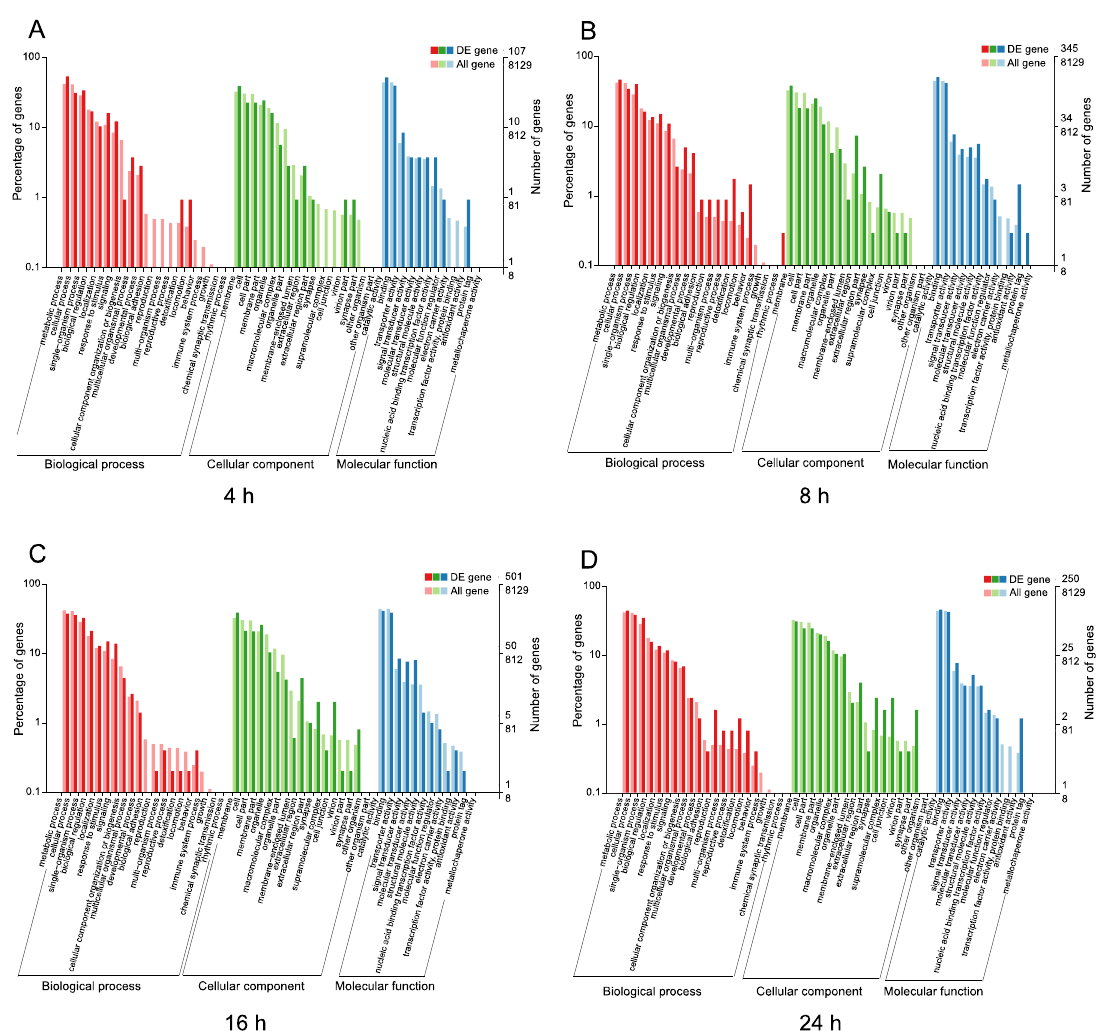
Figure 3. Gene Ontology (GO) categories of N. lugens DEGs after challenge with M. anisopliae at different periods. A: GO categories of N. lugens DEGs after challenge with M. anisopliae at 4 h; B: GO categories of N. lugens DEGs after challenge with M. anisopliae at 8 h; C: GO categories of N. lugens DEGs after challenge with M. anisopliae at 16 h; D: GO categories of N. lugens DEGs after challenge with M. anisopliae at 24 h.